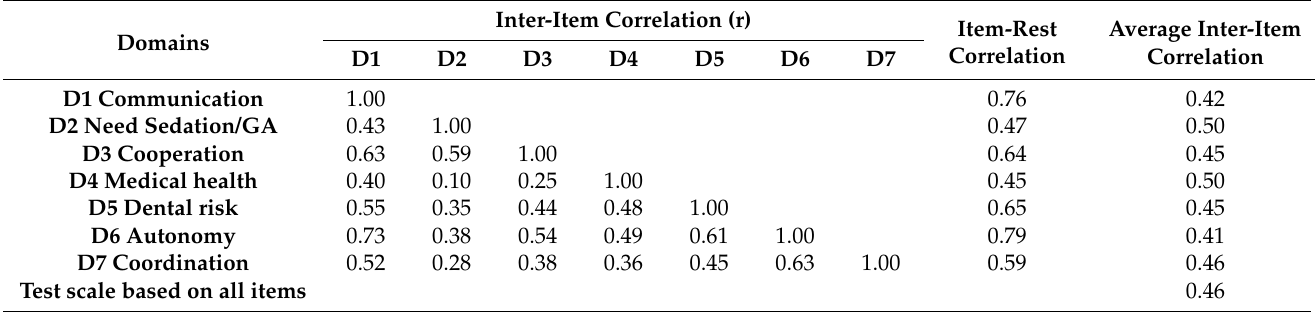
Table 4. Summary of the internal consistency analysis for the national study. Inter-Item Correlation (r) Item-Rest Domains